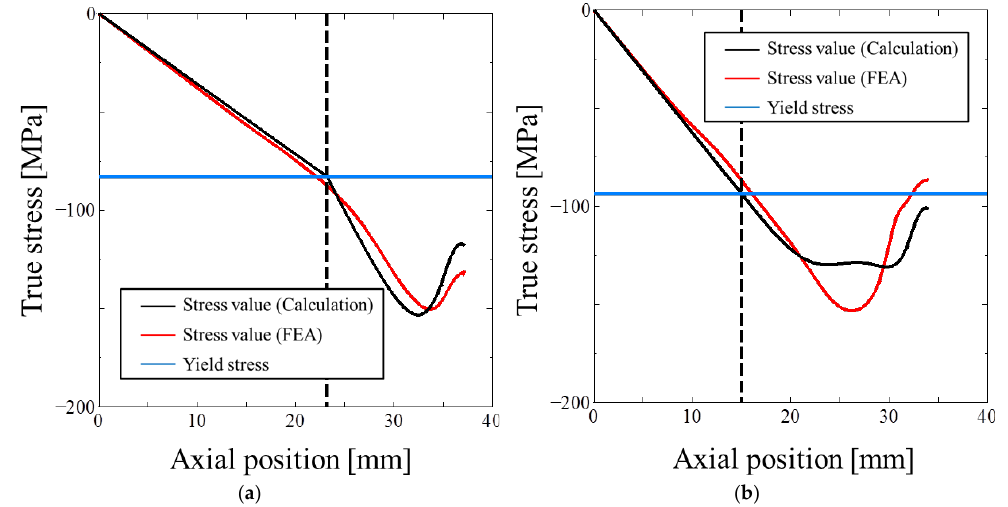
Figure 12. Distribution of axial stress obtained by a bi-linear approximation using Equation (3), the FEA, and the calculated yield stress by Equation (1) at each elapsed time since the impact. ( a ) 20 μs , ( b ) 50 μs. Figure 13 shows the stress-strain curves at each elapsed time. In the figure, the black line is the